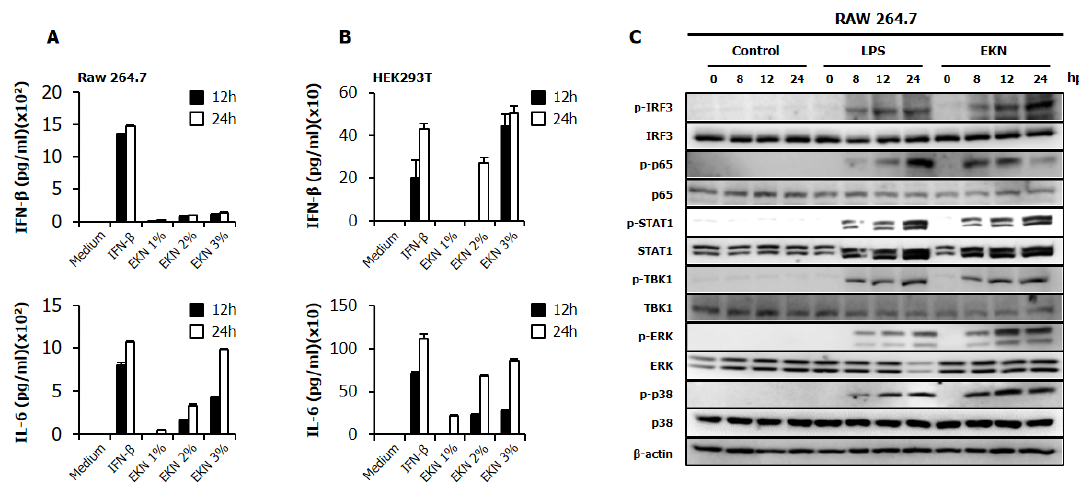
Figure 3. Induction of cytokines and the phosphorylation of the signal molecules by Epimedium koreanum Nakai in vitro. ( A ) RAW264.7; and ( B ) HEK293T cells were treated with DMEM containing 10% FBS alone, with 1000 unit/mL recombinant mouse or human IFN- β , or with 1.0 µ g/mL Epimedium koreanum Nakai (EKN). This was incubated at 37 ◦ C with 5% CO 2 . Supernatant from each group was harvested at 0, 12 and 24 hpt and clarified by centrifugation at 2500 × g for 10 min at 4 ◦ C. Clarified supernatants were dispensed into the murine IFN- β and IL-6 as well as human IL-6 and IFN- β capture antibody-coated ELISA plate to measure cytokine secretion. The test was performed in duplicate for IFN- β and human IL-6 and in triplicate for other cytokines. The data shows the representative means ± SD of each murine cytokine measured over time; ( C ) for the determination of Type I IFN-related or NF- κ B related protein phosphorylation, cells were harvested at 0, 8, 12 and 24 hpt with LPS or Epimedium koreanum Nakai (EKN) and washed with phosphate-buffered saline (PBS), before being subjected to immunoblot analysis. The samples were separated by SDS-PAGE, transferred onto a PVDF membranes and were probed with the target protein antibodies (anti-IRF3/anti-phopho-IRF3, anti-p65/anti-phopho-p65, anti-STAT1/anti-phopho-STAT1, anti-TBK1/anti-phopho-TBK1, anti-p38/anti-phopho-p38, anti-ERK/anti-phopho-ERK, anti- β -actin) before being visualized with the enhanced chemiluminescence detection system (ECL-GE healthcare) using a ImageQuant LAS 4000 mini (GE healthcare, North Richland Hills, TX,